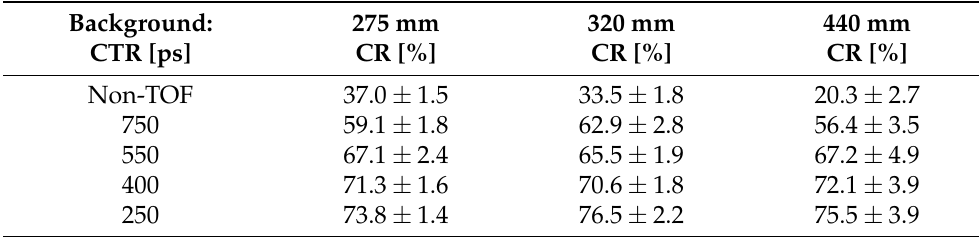
Figure 3. CTR = 750 ps and background diameter 275 mm. Shaded patches represent ± 1 standard error on the mean value. ( a ) Convergence of circles with contrast β = 2.0, at different distances from the center. ( b ) Convergence of circles with different activity contrasts. Table 1. Contrast recovery at 50 updates for the 10 mm sphere with β = 2.0 contrast, as a function of CTR and background diameter. Values reported as mean ± one standard error.